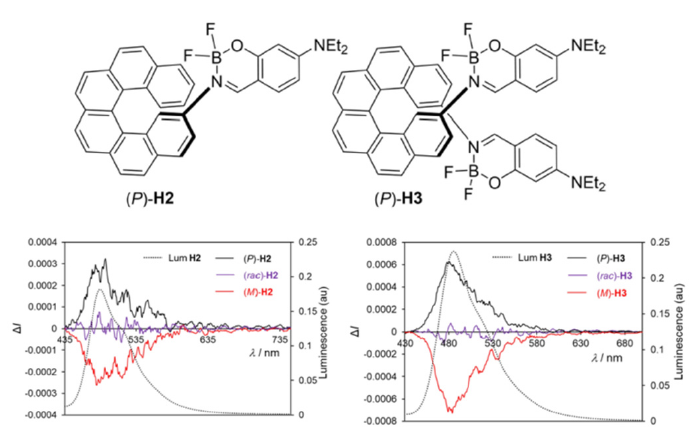
Figure 7. Circularly polarized fluorescent helicene-boranils conjugates [57]. Adapted from Refer- ence [57]. Copyright 2021 John Wiley and Sons.